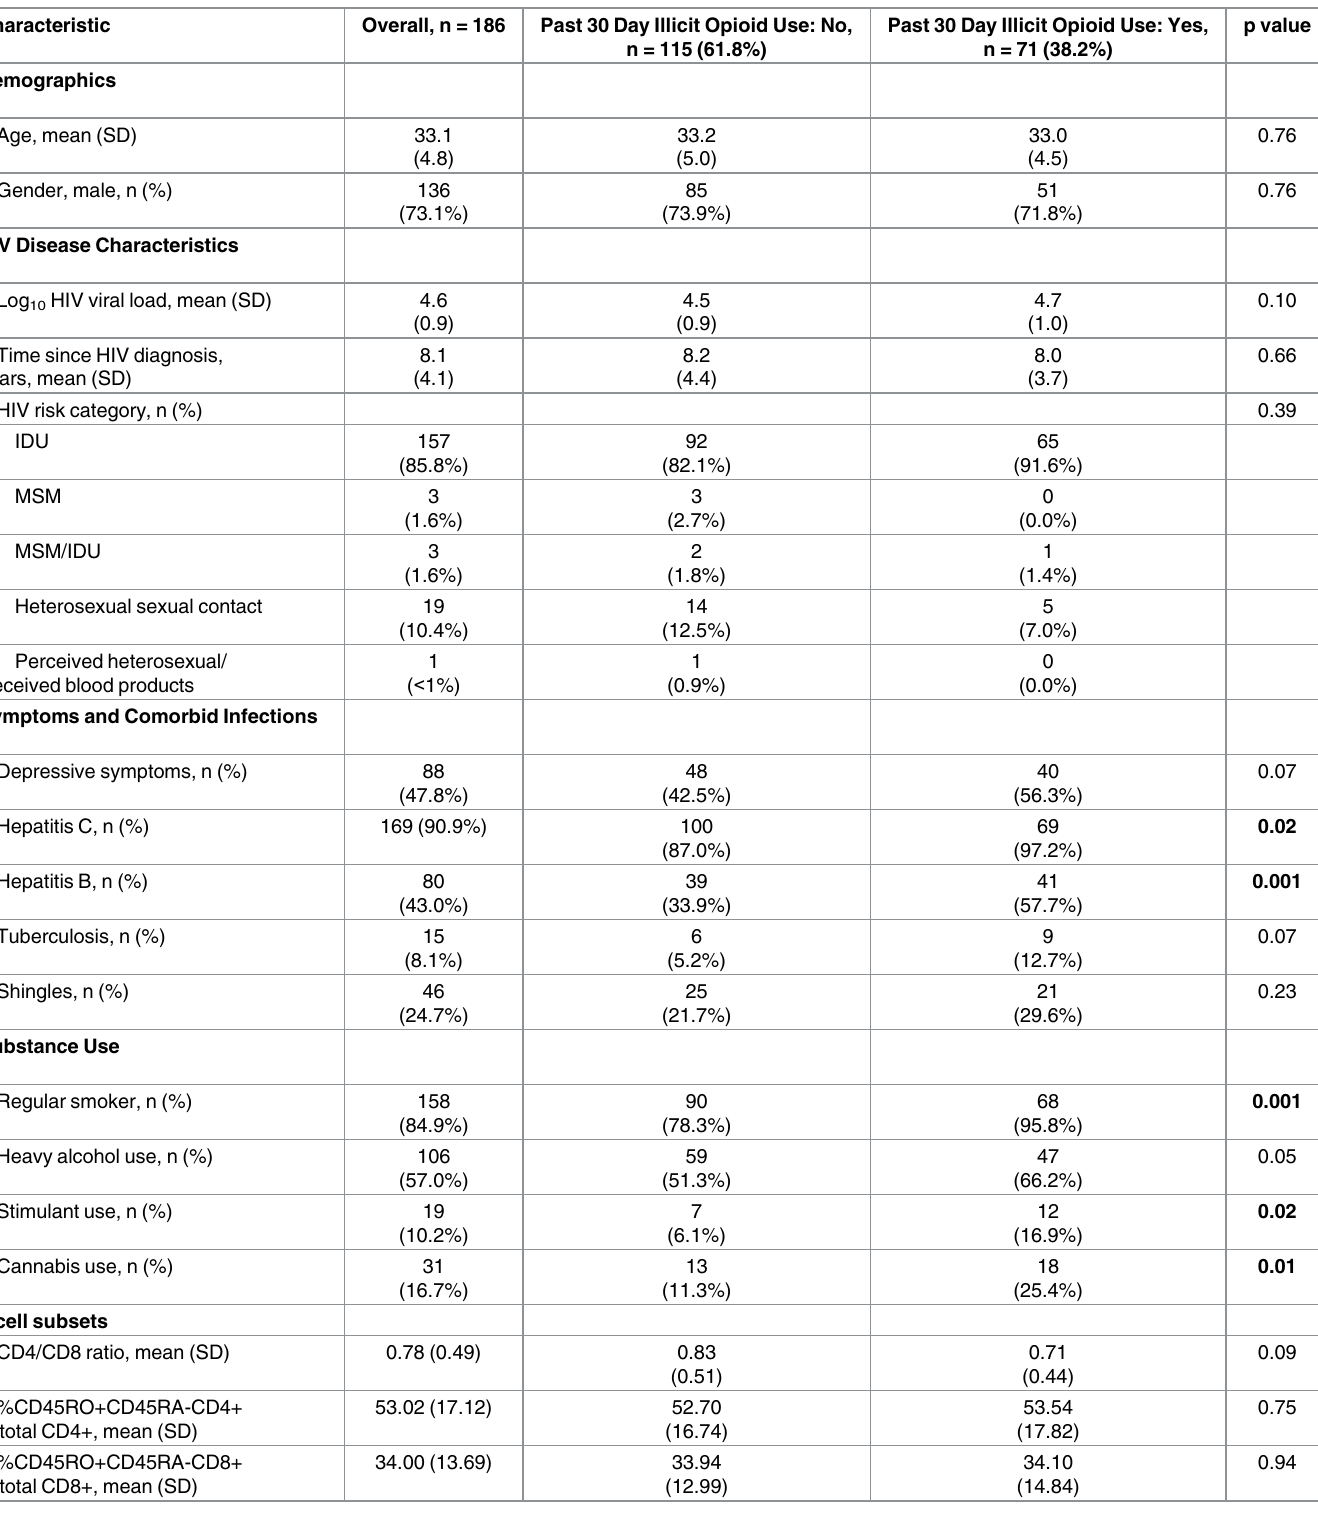
Table 2. Participant demographic and clinical